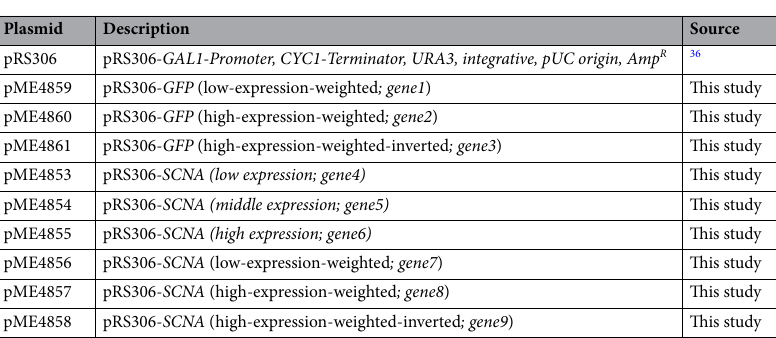
Table 1. Plasmids used in this